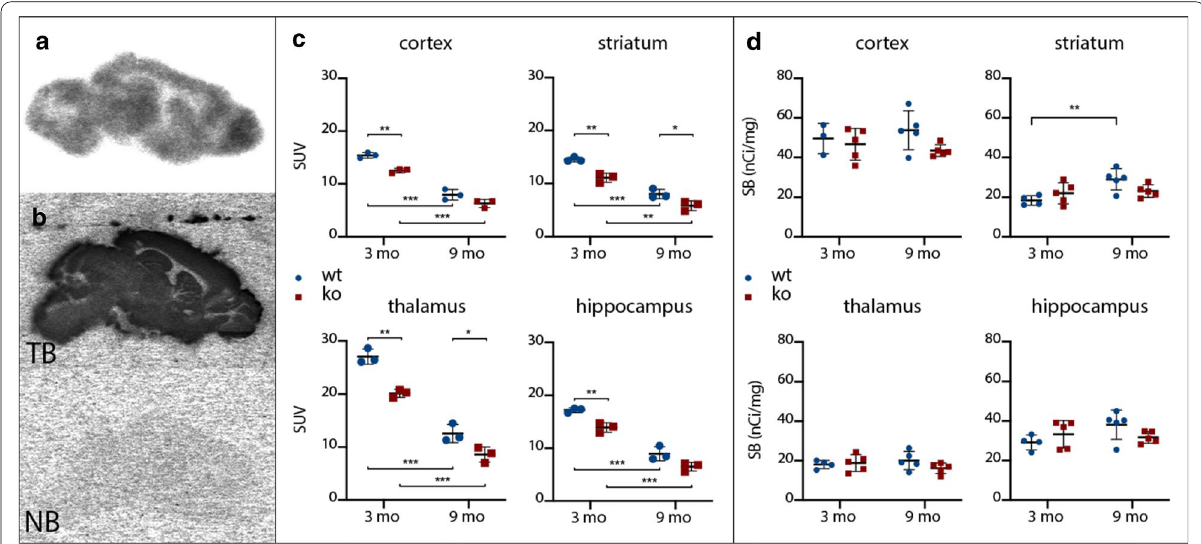
Fig. 4 Representative sagittal autoradiograms of a [ 11 C]UCB-J ex vivo and b [ 3 H]UCB-J in vitro autoradiography with the corresponding regional c standard uptake values (SUV) of [ 11 C]UCB-J ex vivo autoradiography and d specific binding (SB) values of [ 3 H]UCB-J in vitro autoradiography at the age of 3 mo and 9 mo. The corresponding averaged values SD can be consulted in Additional file 1: Table 2. (ko ± NB nonspecific binding; TB total binding; wt wildtype; * p < 0.05; ** p < 0.01; *** p < 0.001) = = =